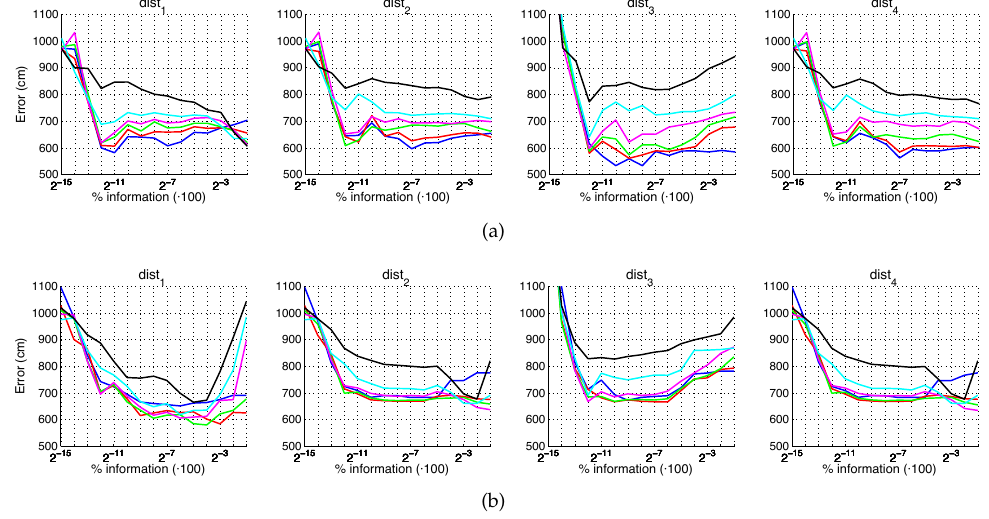
Figure 20. FS average localization error with noise: ( a ) no filter and ( b ) homomorphic filtering. Legend: —– Original, —– Noise 1, —– Noise 2, —– Noise 3, —– Noise 4, —– Noise